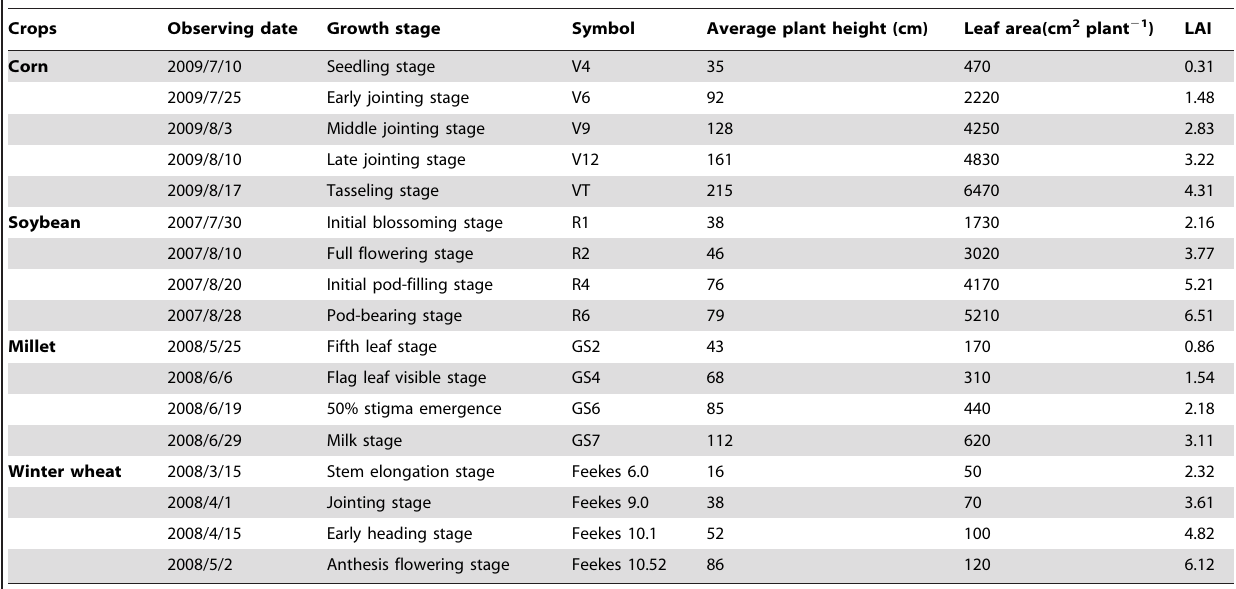
Table 1. Crop growth and vegetative stage at each sampling date.